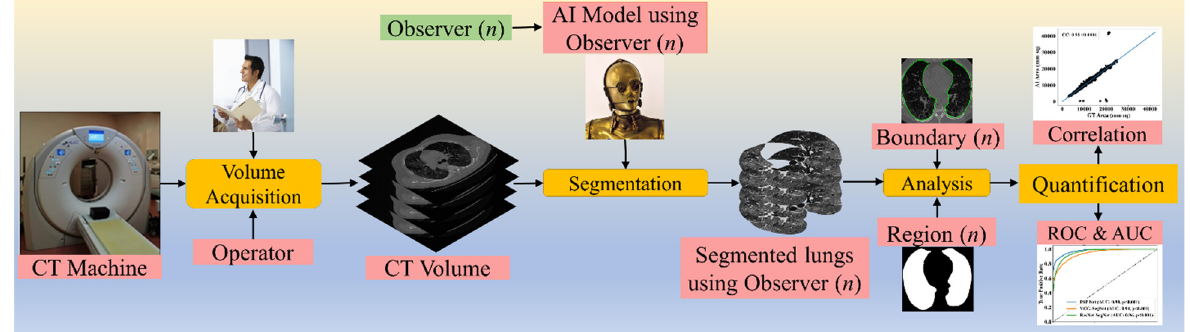
Figure 1. COVLIAS 1.0: Inter-variability analysis of CT-based lung segmentation and quantification system for COVID-19 patients. ROC: Receiver operating characteristic; AUC: Area-under-the-curve.